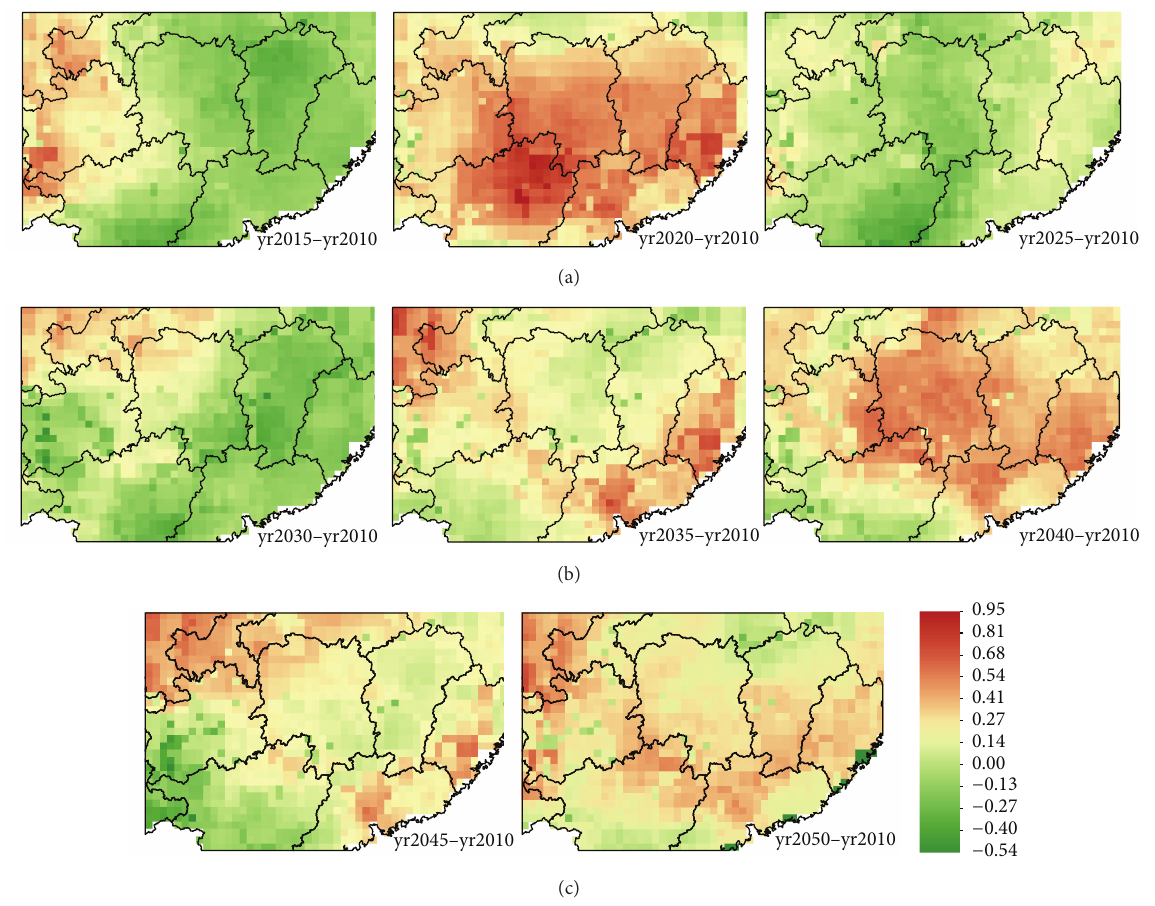
Figure 6: Interannual spatial dynamic of ET (mm year −1 ) in the next 40 years under A2a